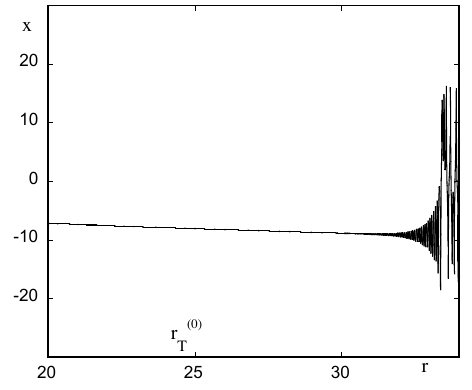
Figure 6. As in Fig. 5 but with (cid:15) = 0 . 1.